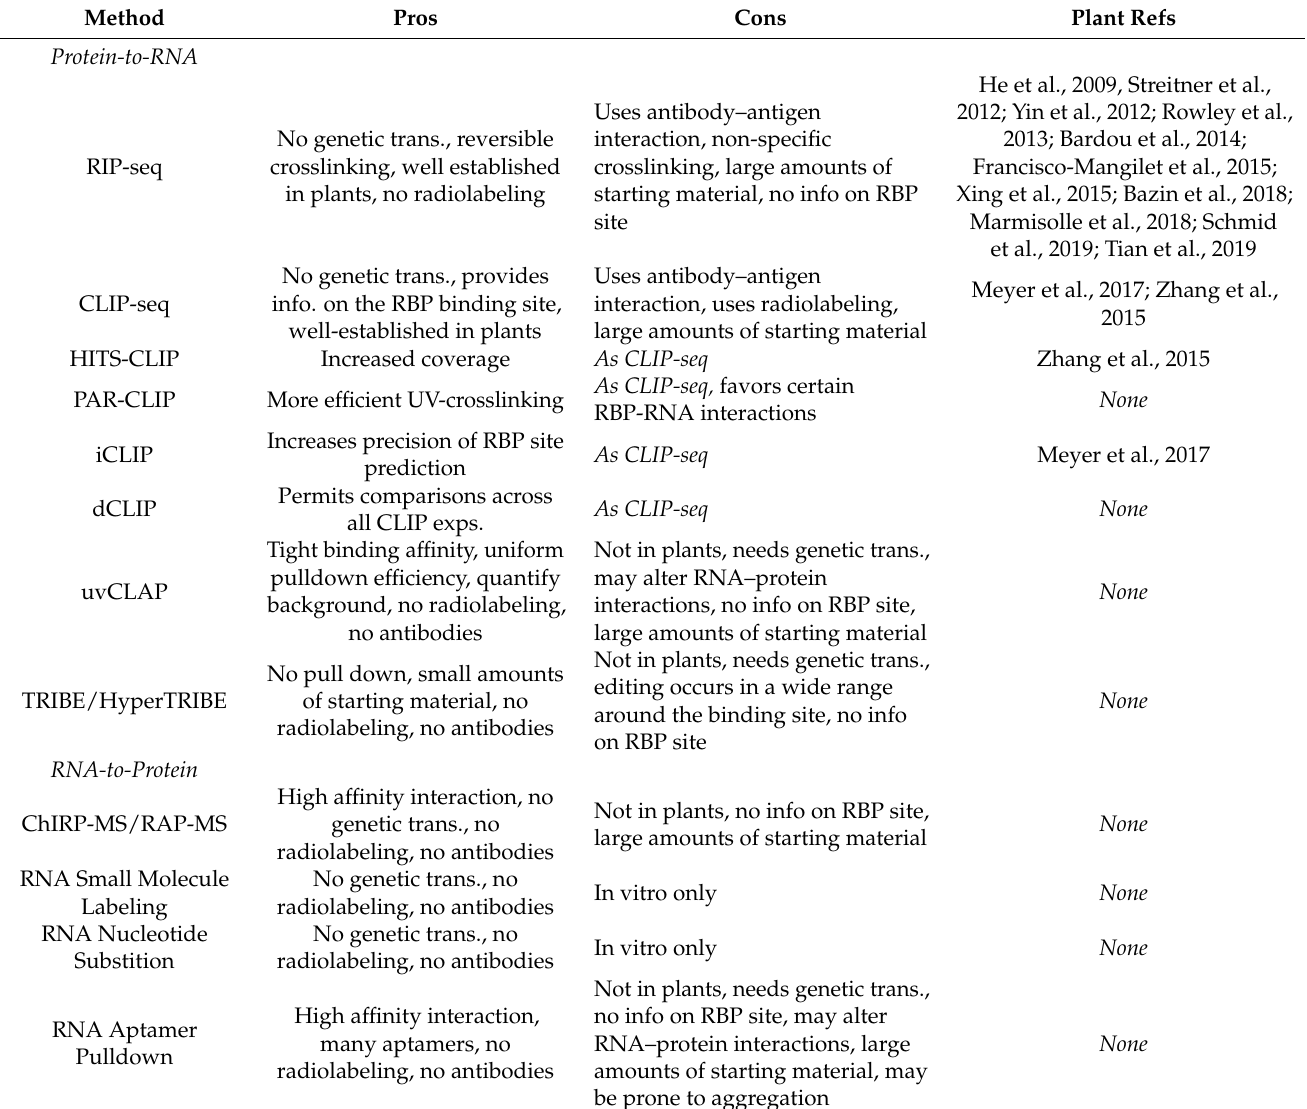
Table 1. Summary of RNA-Protein Methods and their use in